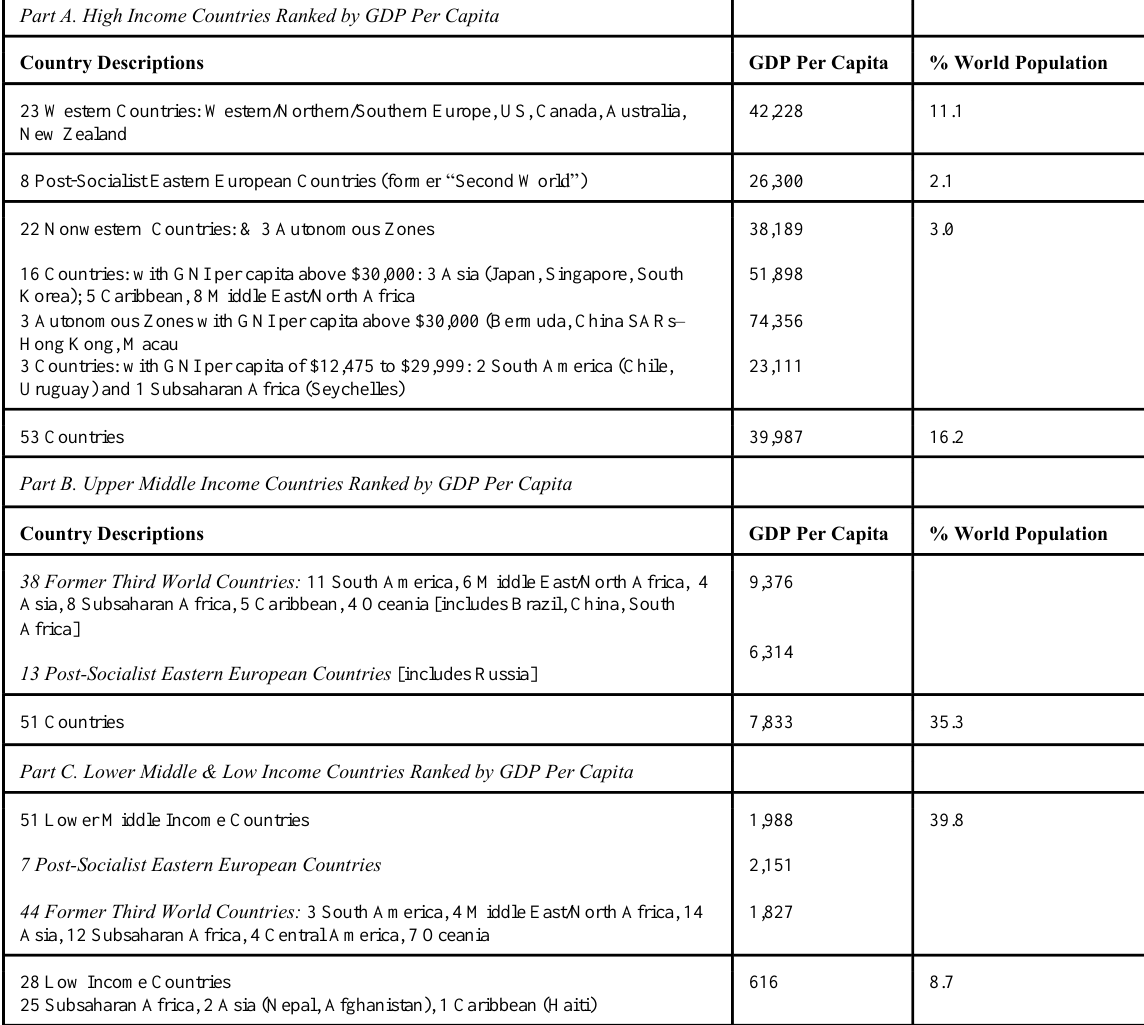
Sources : The list of countries by income group and GDP per capita rankings were acquired from World Bankdatabases. We employ the United Nations (2015) geographical delineations of European